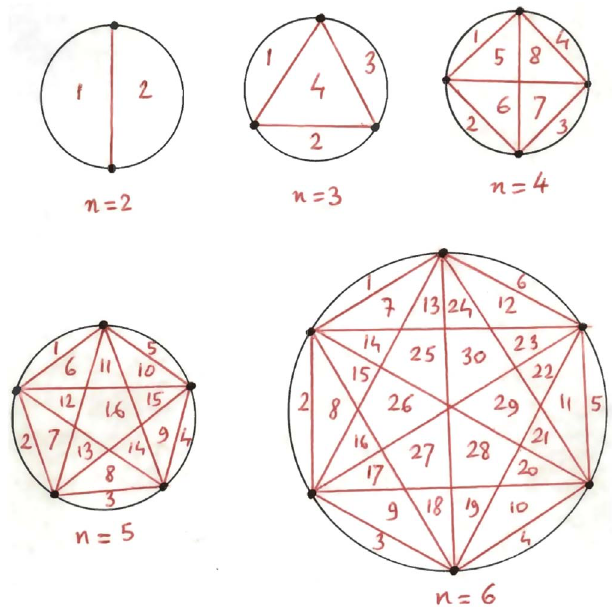
Figure 30. Original drawings of Jos Meeus. For m = n = 5 the original Pythagorean pentagon and pentagram result.